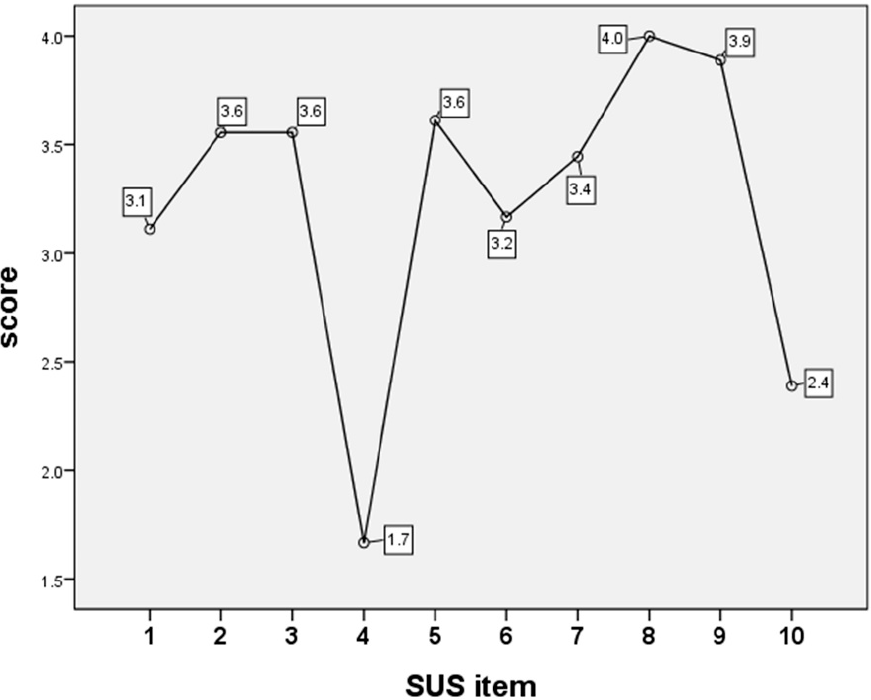
Figure 3. Analysis of variance (ANOVA) analyzed the items of System Usability Scale (SUS) scores shown in Table 1.